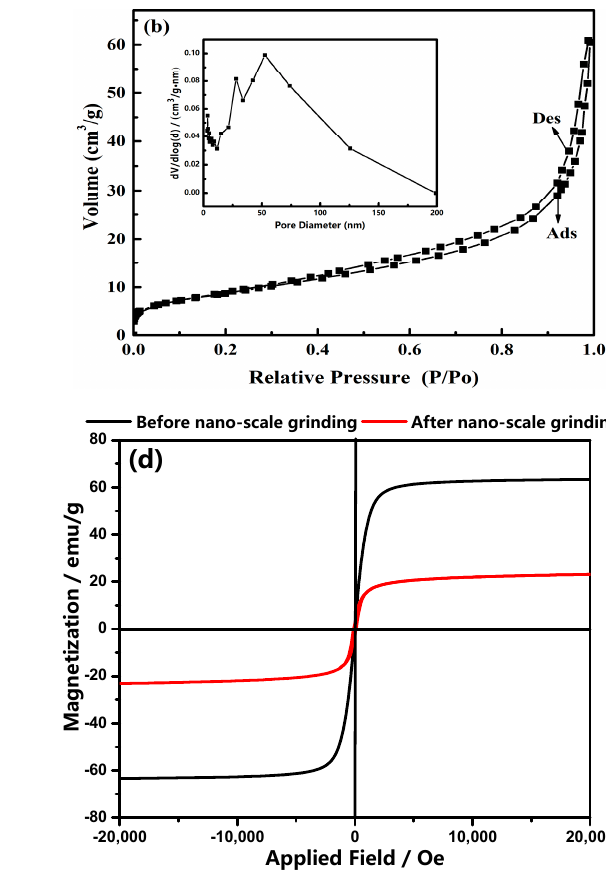
Figure 1. The XRD pattern of MnFe 2 O 4 before and after nano-scale grinding ( a ); the BET adsorption − desorption curve of MnFe 2 O 4 adsorbent ( b ); zeta potential of MnFe 2 O 4 adsorbent ( c ); the magnetization hysteresis loops of MnFe 2 O 4 before and after nano − scale grinding ( d ).